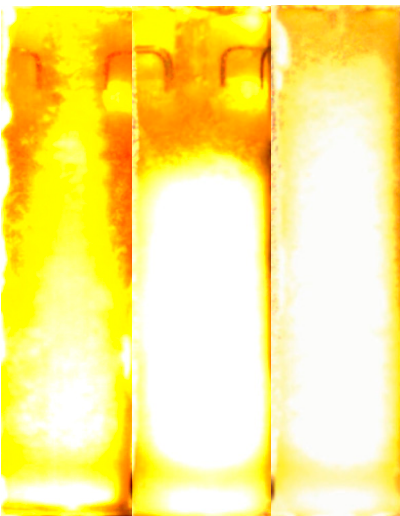
Figure 12. Solidification front images for different geometry of storage units but for the same process time equal to 25 min and the same constant wall temperature condition ( Ts = 17 °C): at left for annular TES, at the middle for shell-and-coil TES with coil position at the bottom of the tank, at the right for shell-and-coil TES with coil position at upper of the tank.